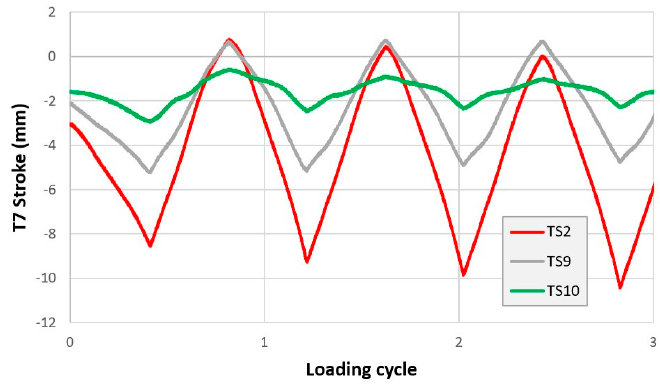
Figure 11. Stroke of T7 transducer versus number of loading cycle during tests at 3.0% drift.